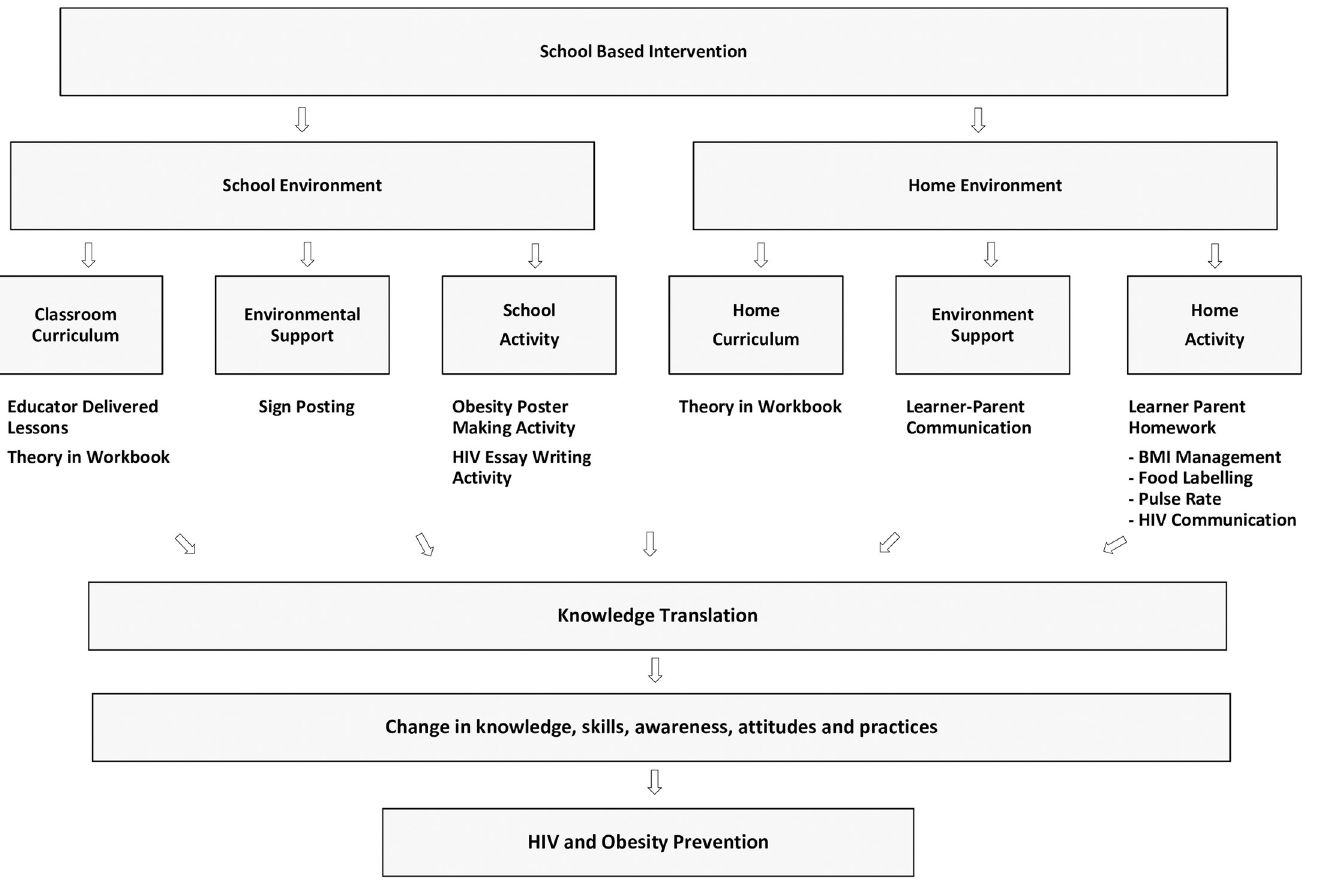
Fig 1. The CIrCLE of Life Initiative. Reprinted from Arthur et al. (2020) under a CC BY license, with permission from Health Education Journal, original copyright 2020 [22].